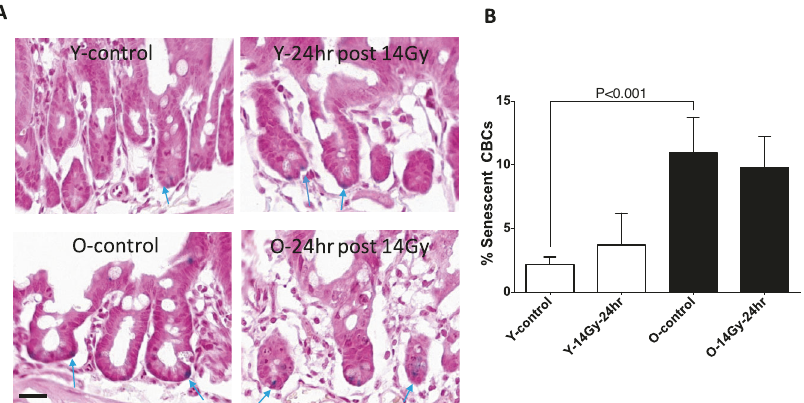
Fig. 5 The sections of proximal jejunum were obtained from young adult and old mice sacri fi ced at 24 h post 14 Gy irradiation. A The senescence-associated β -gal (SA- β -Gal) staining was detected with a commercial kit. Senescent index = positive β -gal CBC/total CBC per jejuna circumference × 100%. Blue arrows indicate senescent CBCs. B Quanti fi cation of percent senescent CBC per jejuna circumference. Data were presented as means ± SD. N = 3 mice/group, 10 circumferences per mouse. *** P < 0.001 Y-control vs O-control, Student ’ s t -test. Scale bar 20